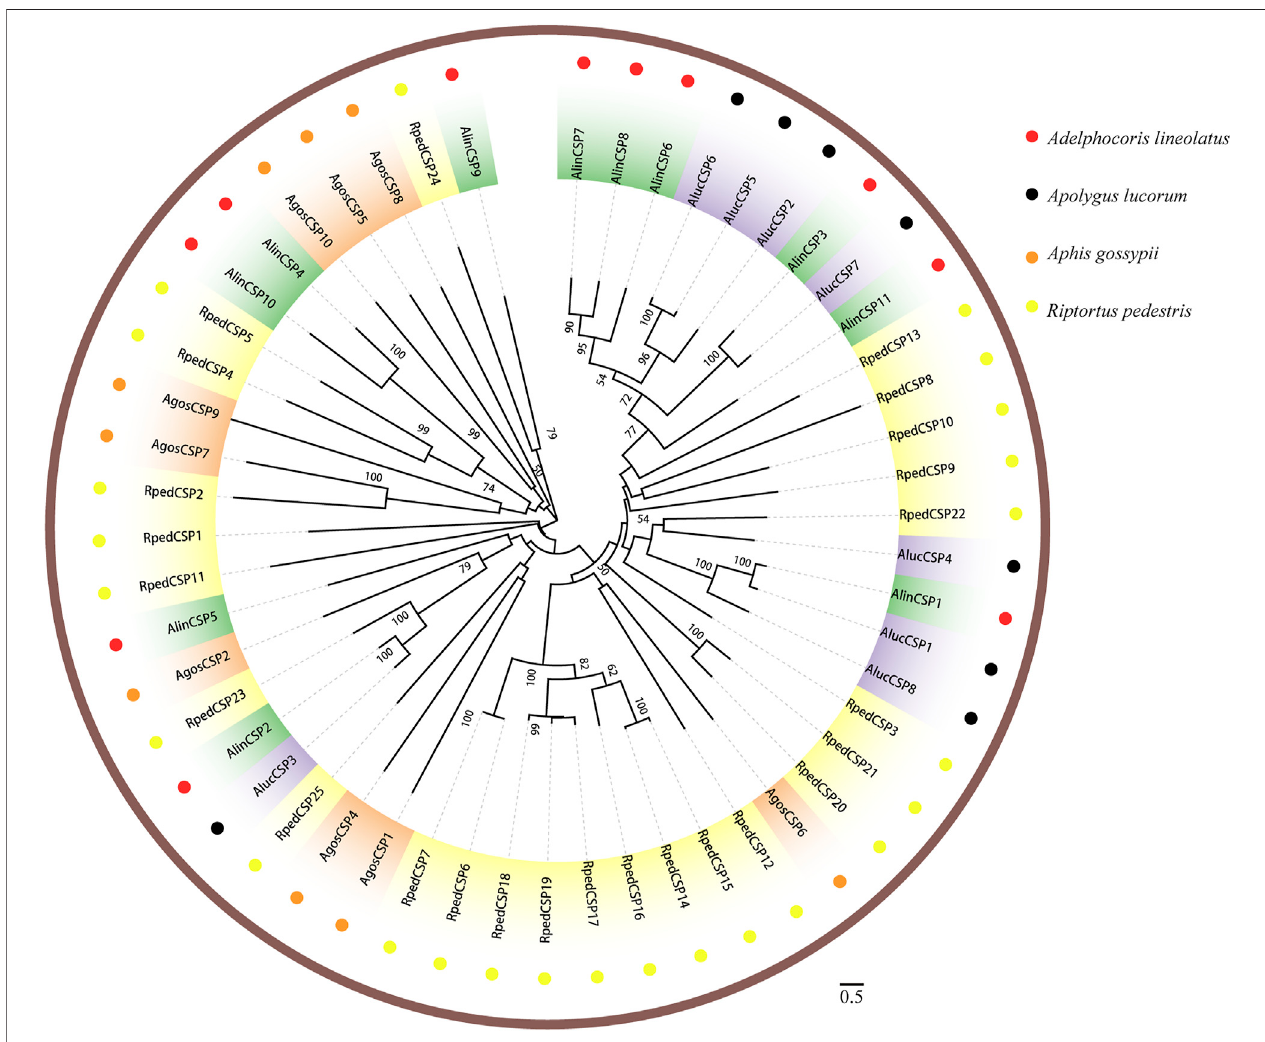
FIGURE 5 | Phylogenetic tree of CSPs. Phylogenetic neighbor-joining tree was constructed using MEGA7 based on alignment results of MEGA7. A phylogenetic neighbor-joining tree was constructed using the CSPs protein that removed signal peptide. Bootstrap values higher than 50 were displayed.